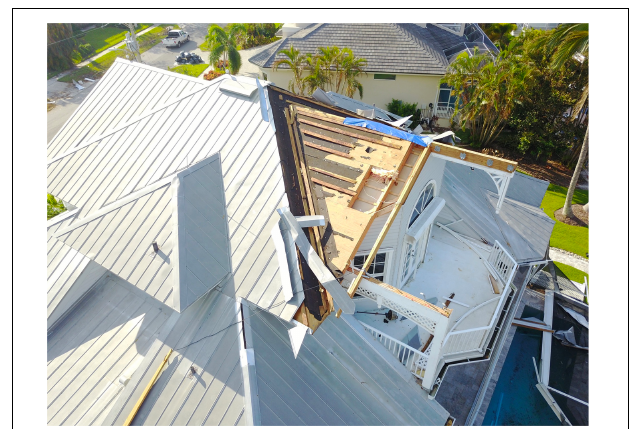
FIGURE 7 | UAVs with high-resolution cameras are well-suited capture perishable data (e.g., roof cover damage, debris field), and provide complementary datasets for ground-based damage surveys. The areal perspective of UAVs reveals structural damage that is hidden from the view of ground-based damage surveyors. Photograph by Kwasi Oerry was acquired under sponsorship from the Florida Building